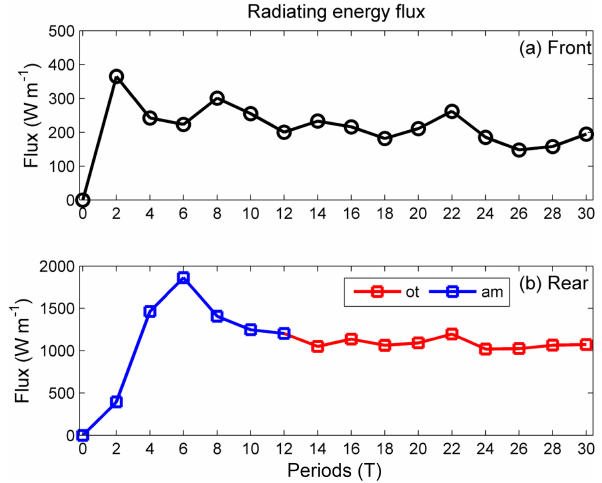
Figure 14. The total energy of the ISW at the different times in case